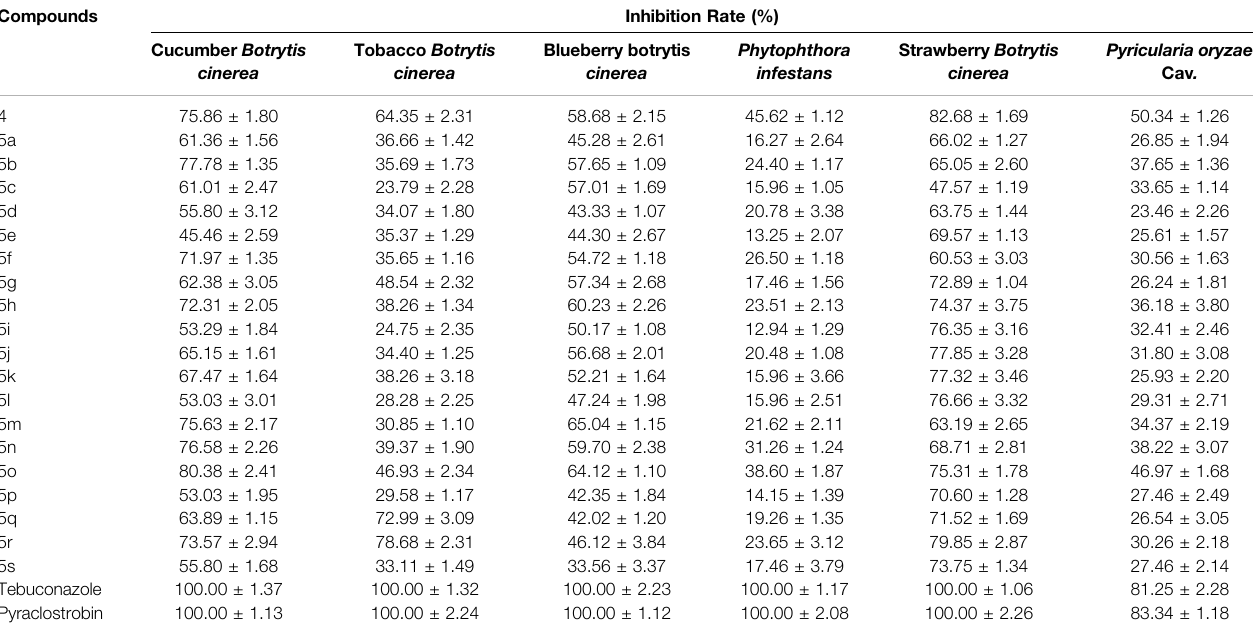
TABLE 1 | The antifungal activities of the compounds 4 and 5a – 5s against plant pathogens of cucumber Botrytis cinerea , strawberry Botrytis cinerea , tobacco Botrytis cinerea , blueberry Botrytis cinerea , Phytophthora infestans, and Pyricularia oryzae Cav . in vitro at 50 μ g/ml.